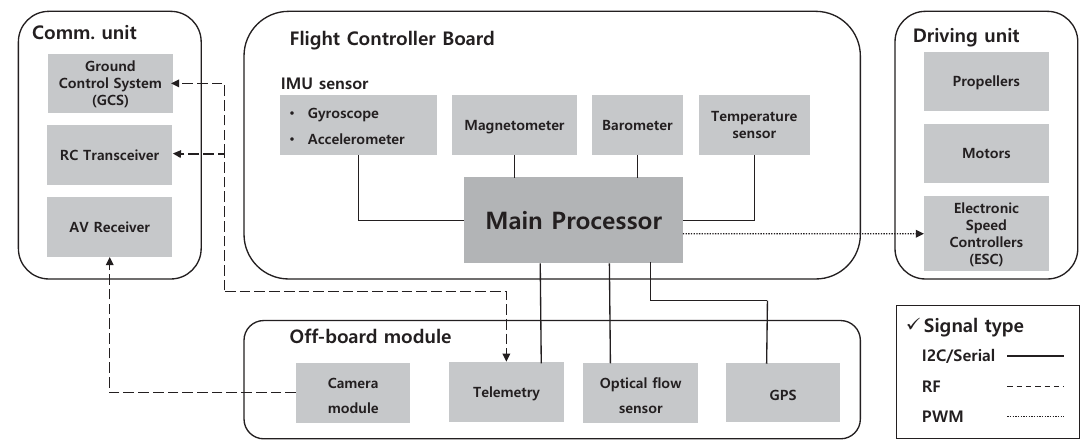
Figure 1. Block diagram of various modules in drone and the signal